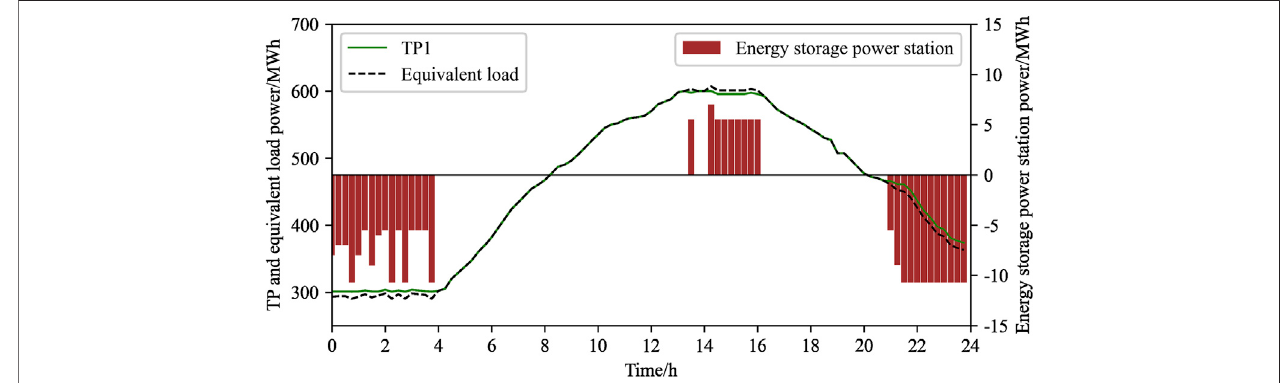
FIGURE 9 | Peak regulation resource output power curve in Model 2.